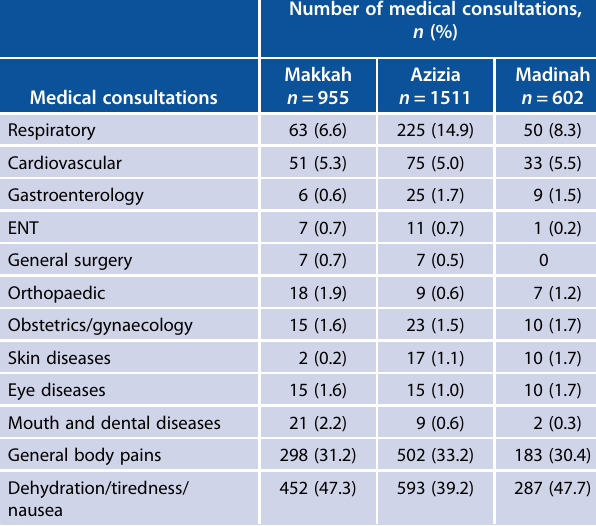
Table 2: Medical consultations among South African Hajj pilgrims ( n = 2000) in 2014